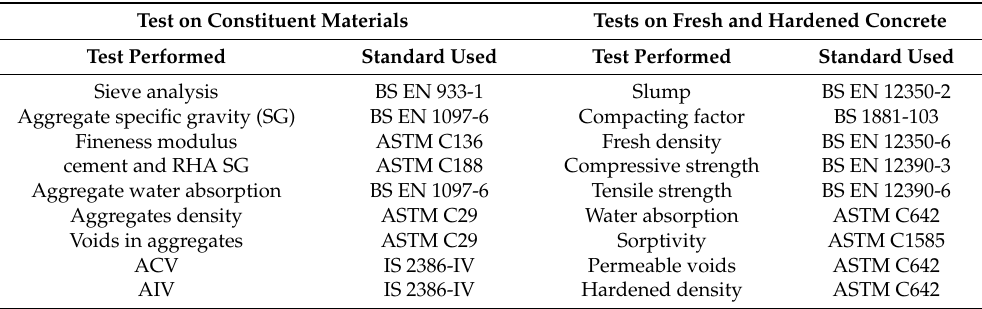
Table 1. Test methods adopted.